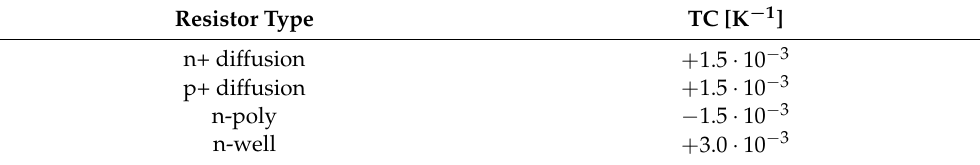
Table 1. First order TCs of different resistor types in a standard 0.18-µm CMOS process